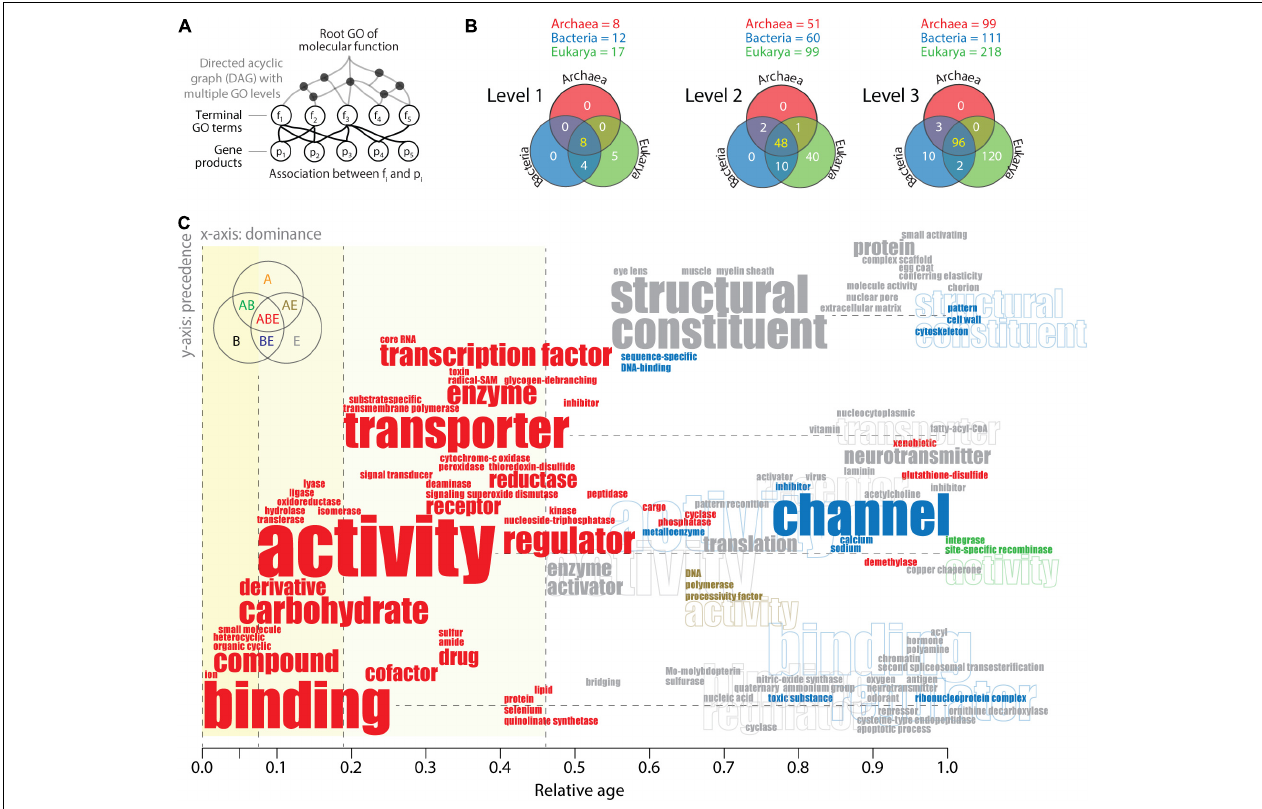
FIGURE 6 | The history of level 2 Gene Ontology (GO) terms of molecular functions visualized with a causal word cloud. (A) The hierarchical structure of the DAG MF . GO terms can be categorized into GO levels by establishing is_a relationships with parental nodes and by including parental nodes into the level if they do not have child nodes (Kim and Caetano-Anollés, 2010). In addition, GO terms that appear as multiple instances in one or multiple levels are collapsed into a single term while excluding those that have part_of and regulation relationships. (B) Venn diagrams describe the distribution of GO terms between superkingdoms, when terms are defined at the three highest levels of the DAG MF . The list of GO terms can be found in Koç and Caetano-Anollés (2017) and term definitions in AmiGO 2 (http://amigo.geneontology.or/amigo/dd_browse) of the GO classification (Ashburner et al., 2000). (C) Word cloud of level 2 GO terms ordered according to evolutionary dominance (x-axis) and precedence in the lexical chain (y-axis). See text for description of the approach and algorithmic implementation. Word clouds were generated separately for each Venn taxonomic group of GO terms and then combined. Repeated lexical units are identified with outline fonts. Data from Koç and Caetano-Anollés